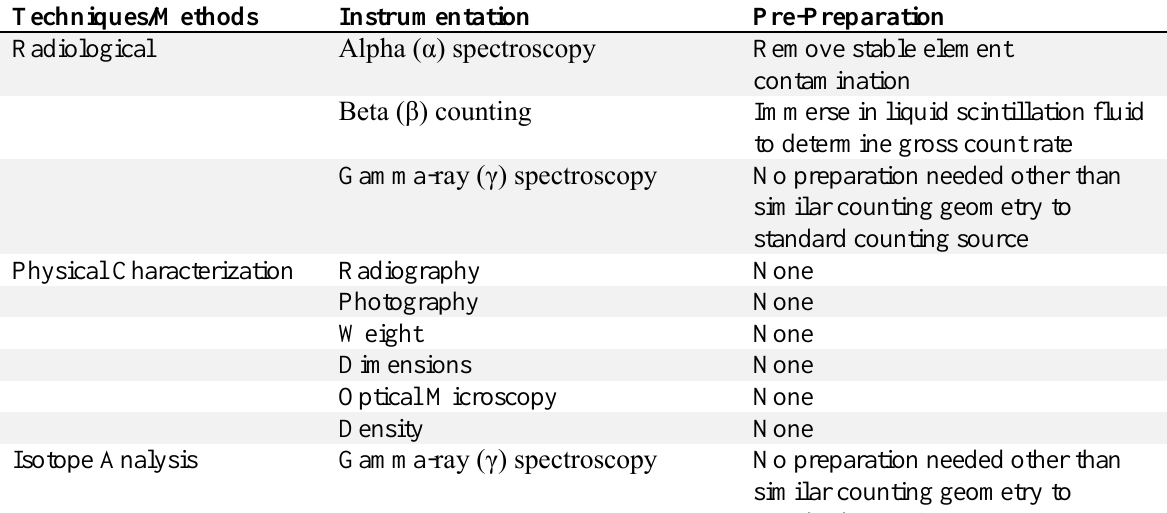
Table 2. Post-Detonation Nuclear Forensic Techniques [ 23